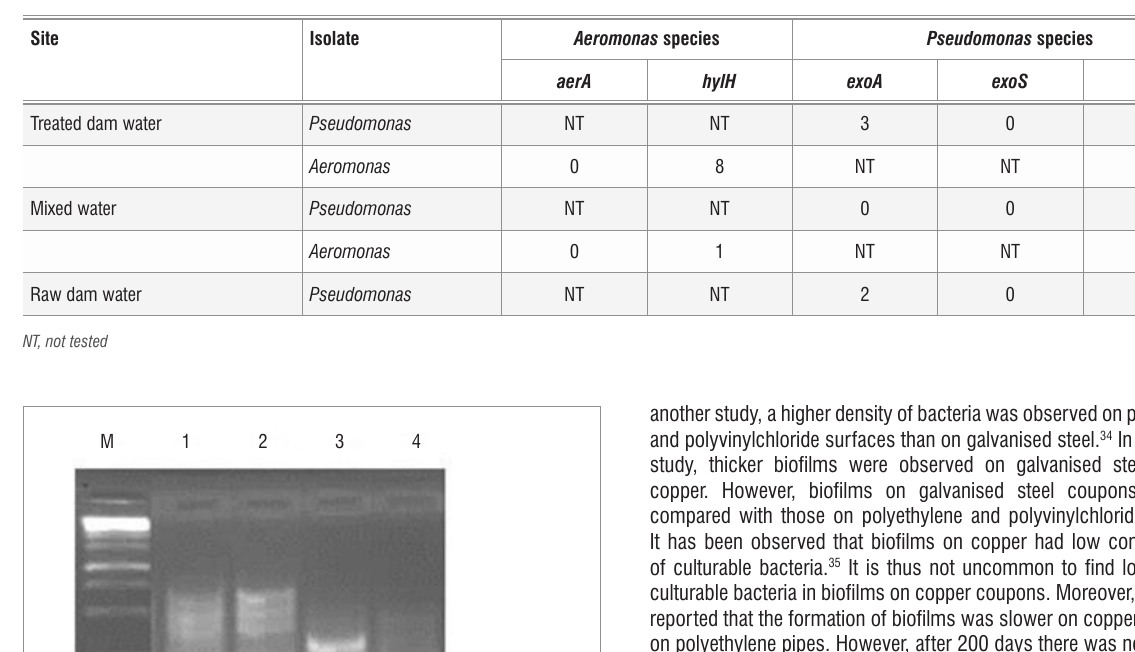
Table 5: Virulence gene determinants detected in isolates from the different